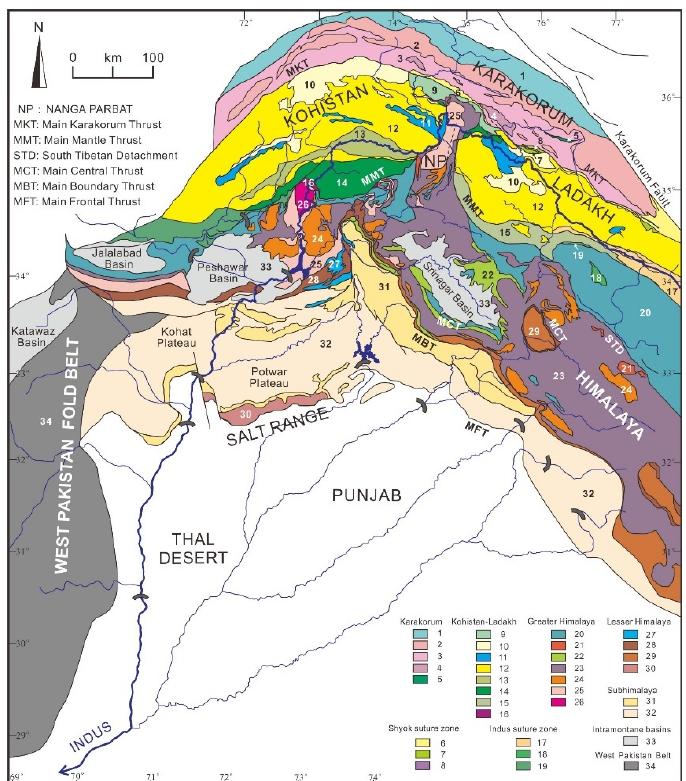
Figure 2. Geological map of the Indus catchment in northern Pakistan (modified from Pêcher et al. [34]). Geological units, from north to south: Karakorum belt : 1: northern sedimentary belt; 2: axial batholith and other granitoid rocks; 3: southern metamorphic belt; 4: felsic gneiss; 5: Masherbrum Greenstone Complex. Shyok suture zone : 6: mostly terrigeneous strata; 7: mélange zone (mainly volcanic